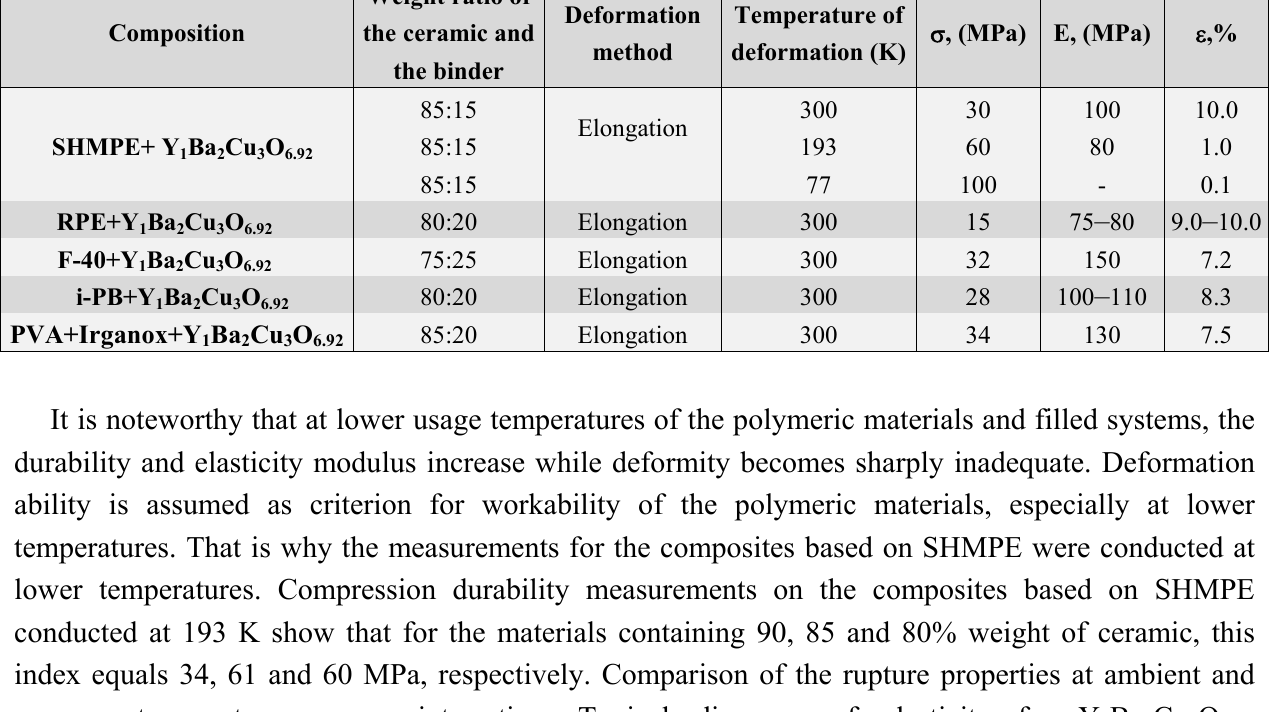
Ba Cu O nanocomposites with SHMPE, obtained 1 2 3 6.97